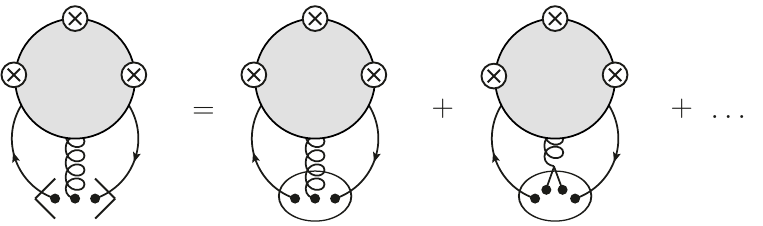
Figure 2. A graphical illustration of the propagation formula (3.9c). The notation corresponds to the one already explained in (cid:12)gure